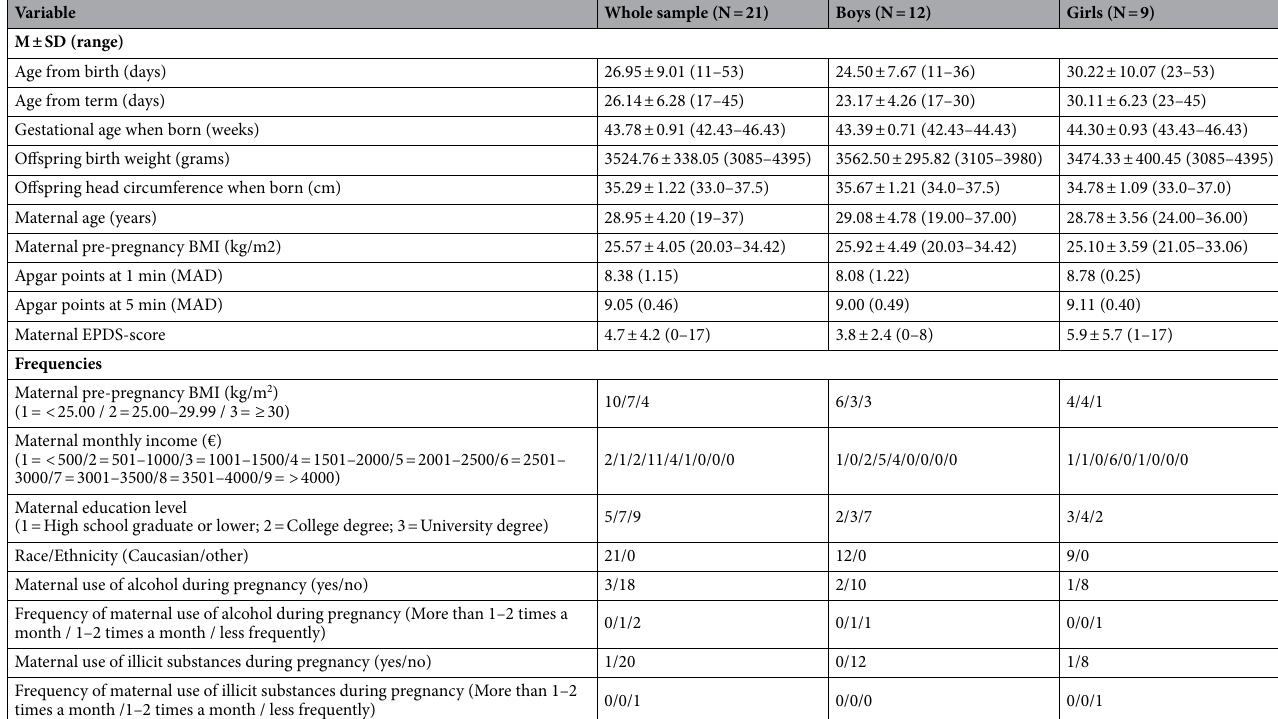
Table 1. Sample demographics of included dyads (N = 21) comprising of neonates and mothers that participated in this study. Variable selection was based on previous recommendations 41 . Abbreviations: M = Mean; SD = Standard deviation; MAD = Mean absolute deviation; EPDS = Edinburgh postnatal depression scale 10-point questionnaire sum score filled out at 24th gestational